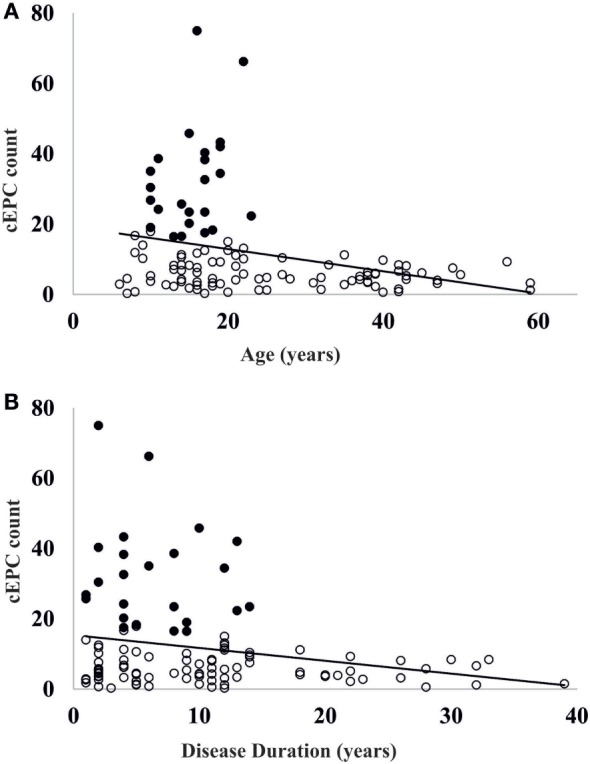
(A) Scatter plot of the distribution of circulating endothelial progenitor cell (cEPC) vs age. Black circles: patients with high endothelial progenitor cell (EPC) count. (B) Scatter plot of cEPC vs disease duration. Black circles: patients with high EPC count.